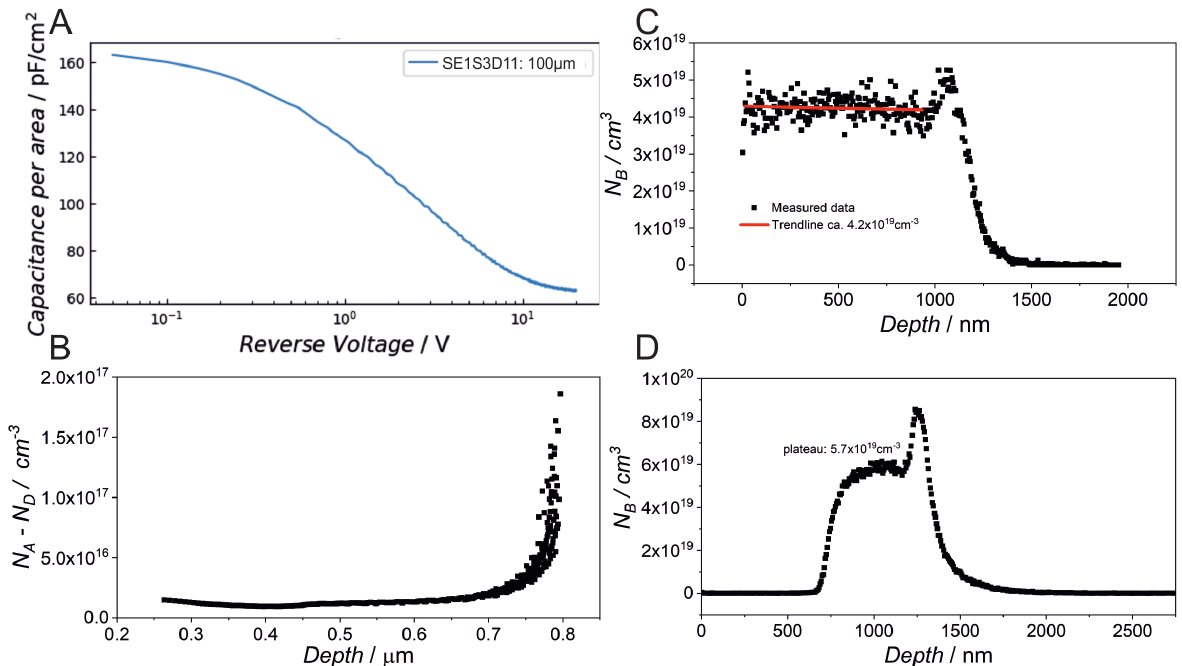
Figure 2. ( A ): CV measurement for diode SE1S3D11 on a sample (denoted I in Table 1 below) prepared as shown in Figure 1A; ( B ): carrier concentration determined from fitting the second derivative of the CV measurement; ( C ): SIMS after the growth of the p + layer before polishing; ( D ): SIMS at the final stage in one of the least polished locations.